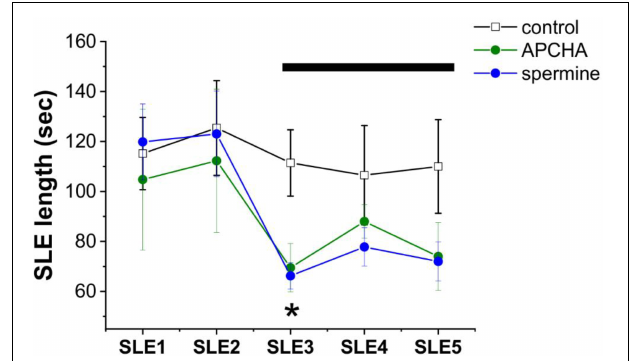
FIGURE 2 | Inhibition of spermine synthesis and exogenous spermine addition both inhibits seizure-like events in the in vitro low-[Mg 2 + ] model of temporal lobe epilepsy. Length of seizure-like events (SLEs), measured in the CA3 pyramidal layer of hippocampal slices under control conditions and in the presence of the spermine synthase inhibitor 3-(aminopropyl)cyclohexylamine (APCHA) (200 µ M) or exogenous spermine (200 µ M) ( n = 4–6 animals). Drugs were applied after two fully developed SLEs in the low-[Mg 2 + ] ACSF. Bar shows the application period of APCHA or spermine. Asterisks denote significant ( p < 0.05) difference from the